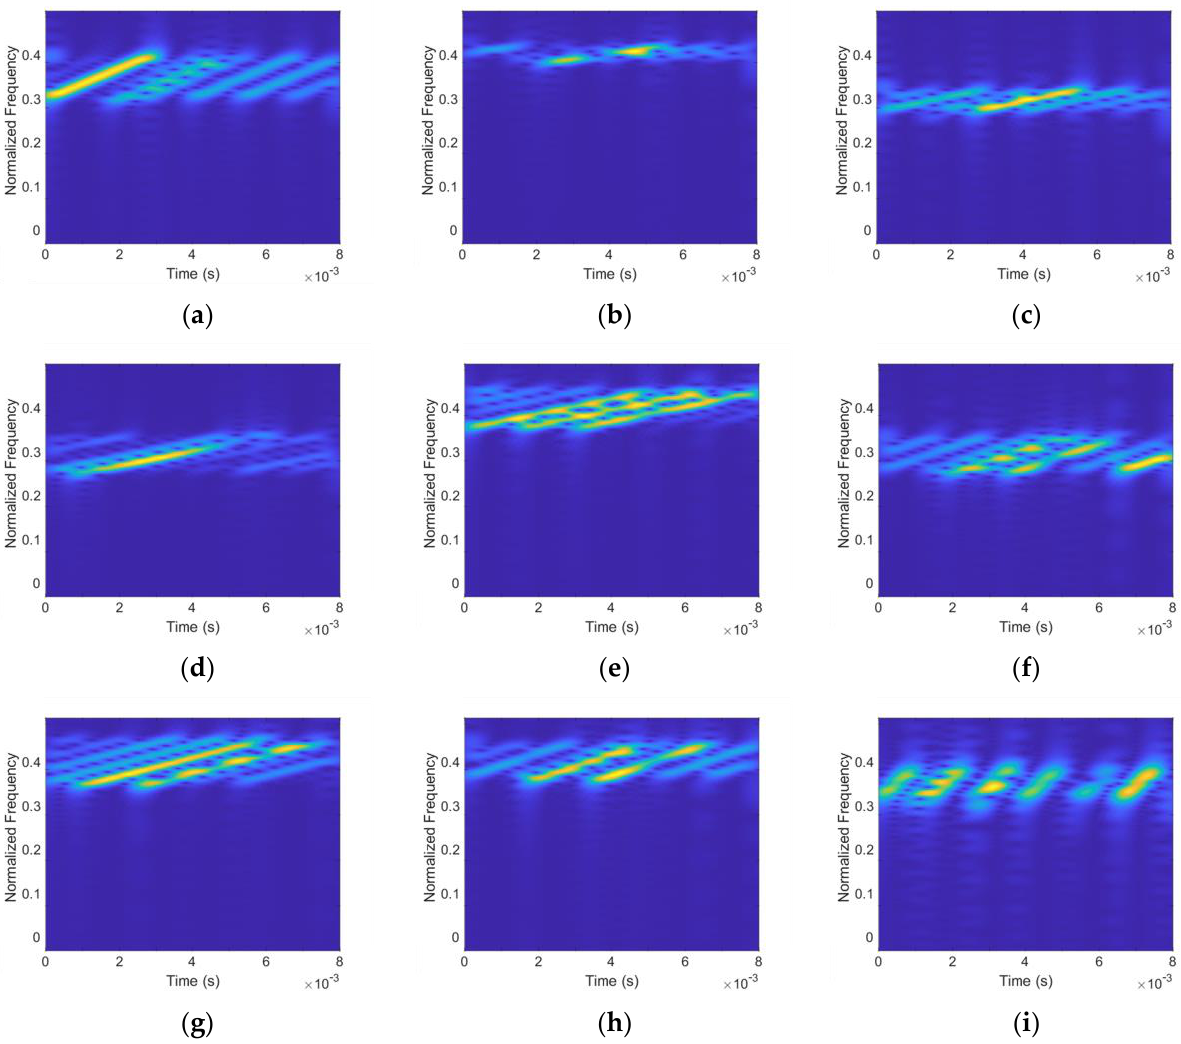
Figure 4. STFT spectrogram of nine observed signals in the training dataset. Frequency, bandwidth, and pulse width for each plot are, respectively, ( a ) 35 kHz, 10 kHz, 3 ms; ( b ) 40 kHz, 5 kHz, 3 ms; ( c ) 30 kHz, 5 kHz, 3 ms; ( d ) 30 kHz, 10 kHz, 5 ms; ( e ) 40 kHz, 10 kHz, 5 ms; ( f ) 30 kHz, 8 kHz, 3 ms; ( g ) 40 kHz, 10 kHz, 5 ms; ( h ) 40 kHz, 8 kHz, 3 ms; ( i ) 35 kHz, 8 kHz, 1 ms.